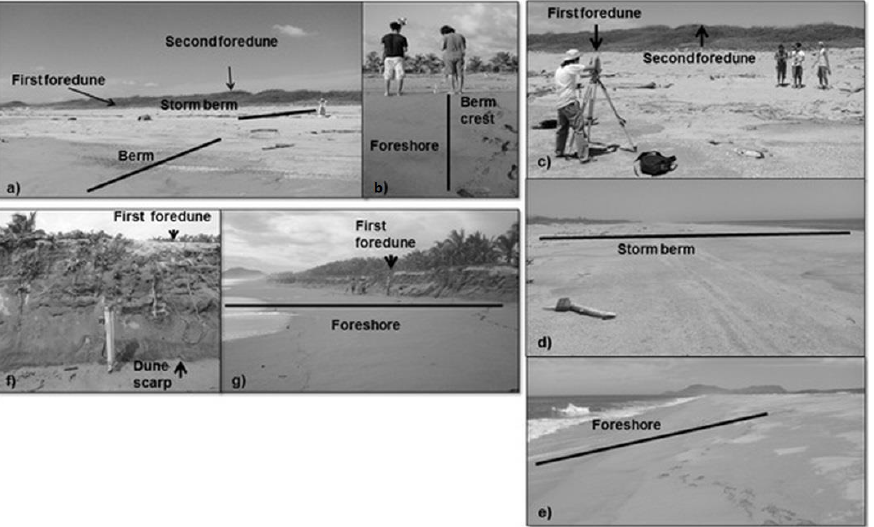
Figure A2. ( a , b ) Low-energy beach profile; ( c – e ) moderate-energy beach profile; ( f , g ) high-energy beach profile.